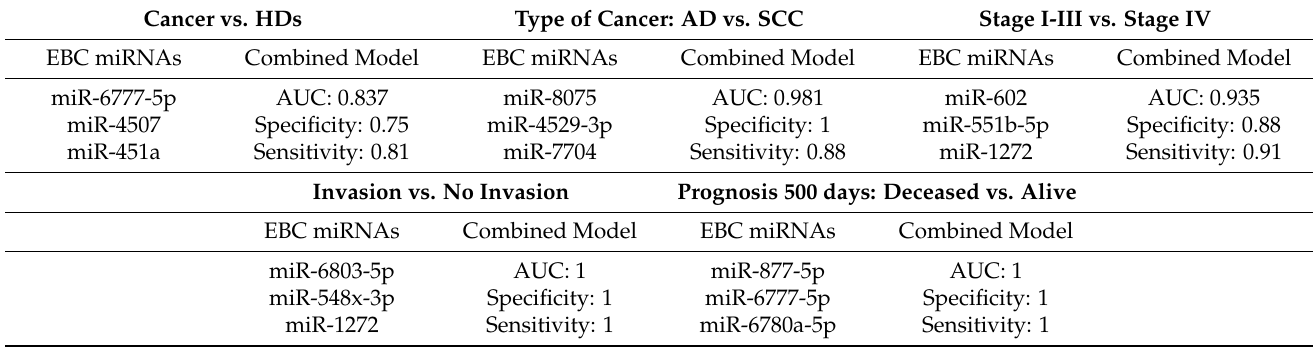
Figure 6. ( A ) Volcano plot showing fold change (FC) and statistical significance of individual miRNA levels in the breath condensate of lung cancer patients who were deceased after 500 days and those alive. Blue and red dots represent negatively and positively regulated miRNAs respectively ( p < 0.05). ( B ) Regulated miRNAs calculated PCA plots showing the PC1 and PC2 scores for individual lung cancer patients alive (blue dots) and deceased (orange dots). ( C ) Heatmap showing z-score of miRNAs regulated in EBC from lung cancer patients who died and are alive after 500 days. ( D ) Accuracy of invasion capacity prediction calculated by LOOCV models for individual miRNAs and for the four possible combinations. ( E , F ) ROC curves predicted for an individual ( E ) and combined miRNAs ( F ) selected through a random forest iteration model. Table 2. EBC miRNAs with potential as biomarkers in lung cancer. Cancer vs. HDs Type of Cancer: AD vs.